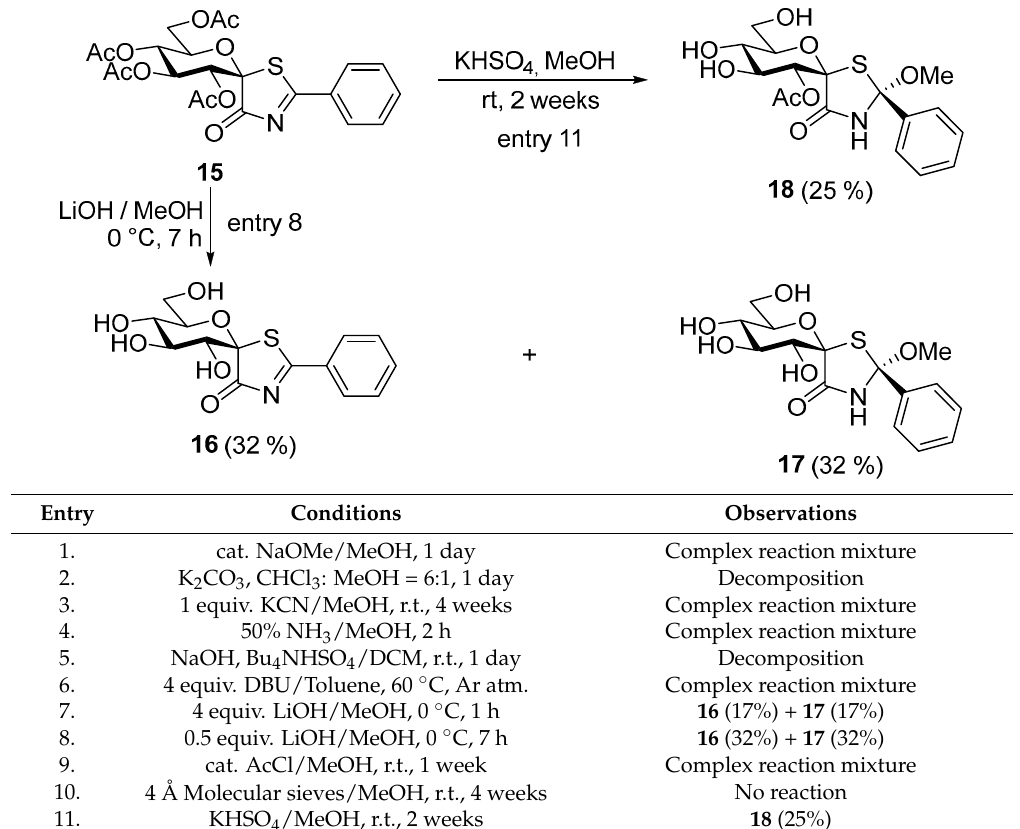
Molecules 2017 , 22 , 1760 Table 2. Observations during experiments for deacetylation [29] of spiro-thiazolinone 15 .